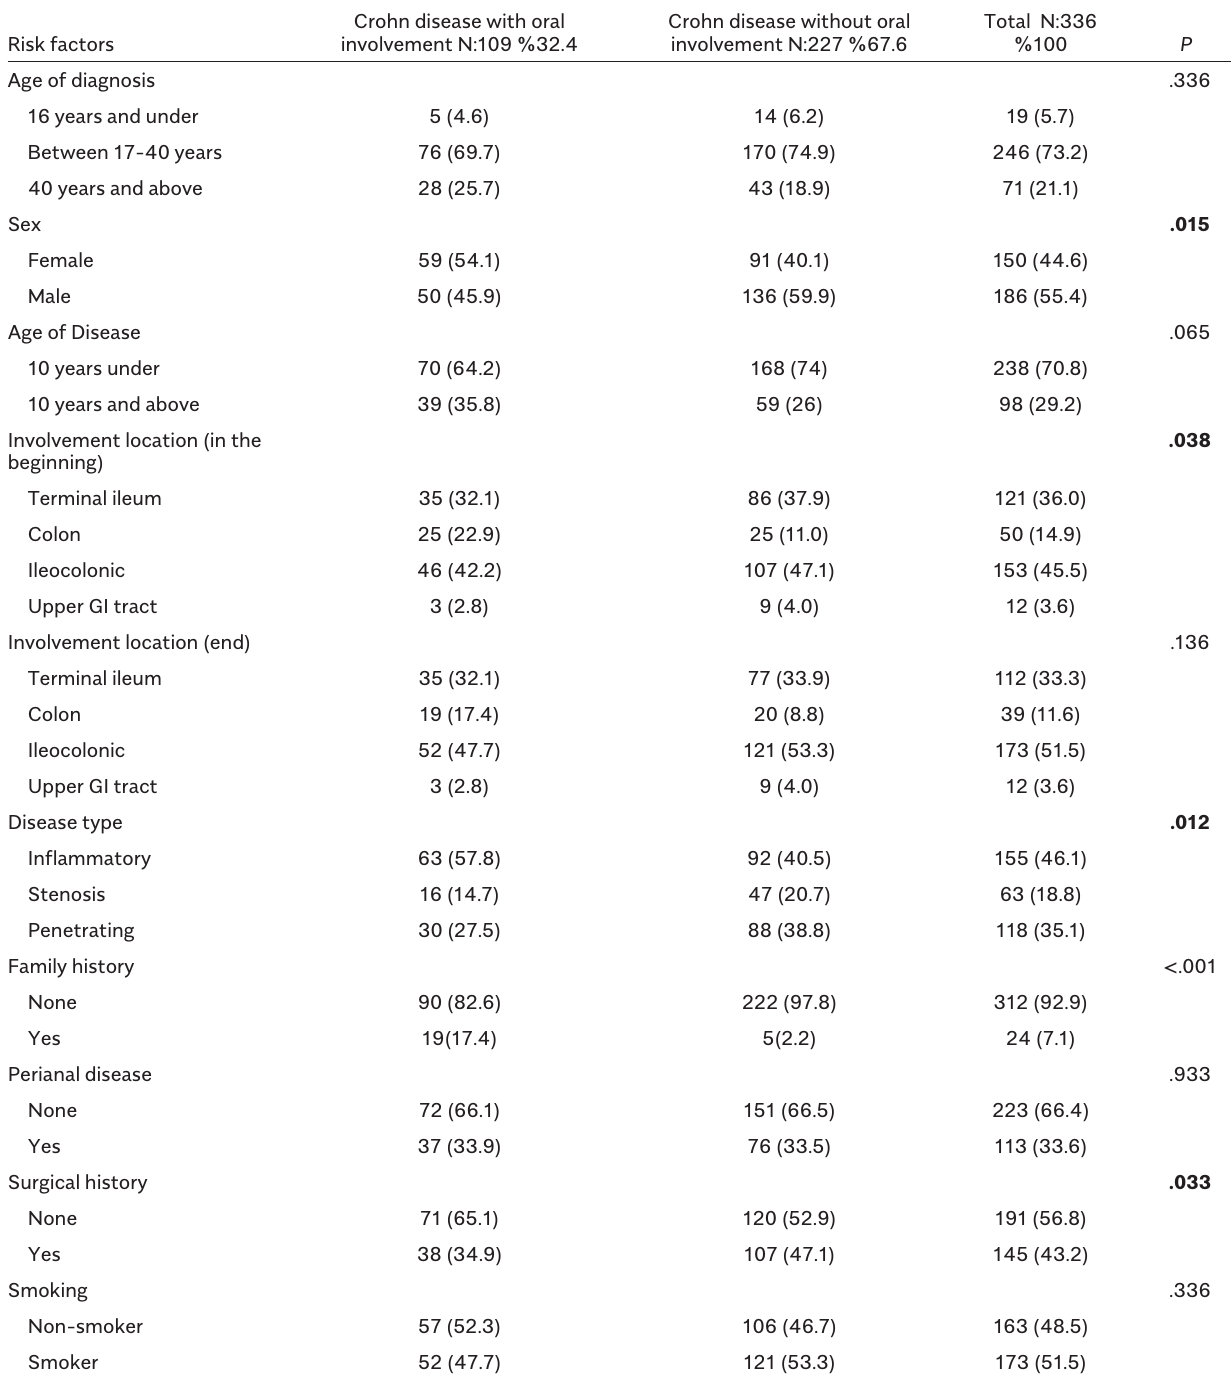
Table 3. The Relationship Between Oral Involvement and Risk Factors in Crohn’s Patients Risk factors